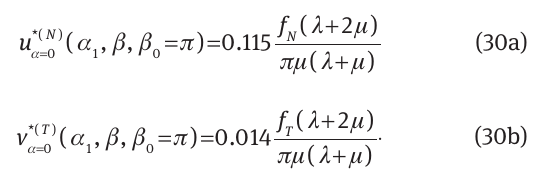
Figure 6 Contour maps of the normal tangential force. Coordinate x is a coordinate of the measured displacement; x expressed in units of the radius of the hole ρ ; the displacements are presented in units of , gential force; and λ , μ are the elastic modules. The distance between the center of the hole and the planar surface is d = 1.54 ρ